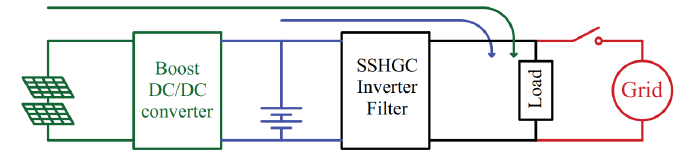
Figure 7. Power operation mode 4.